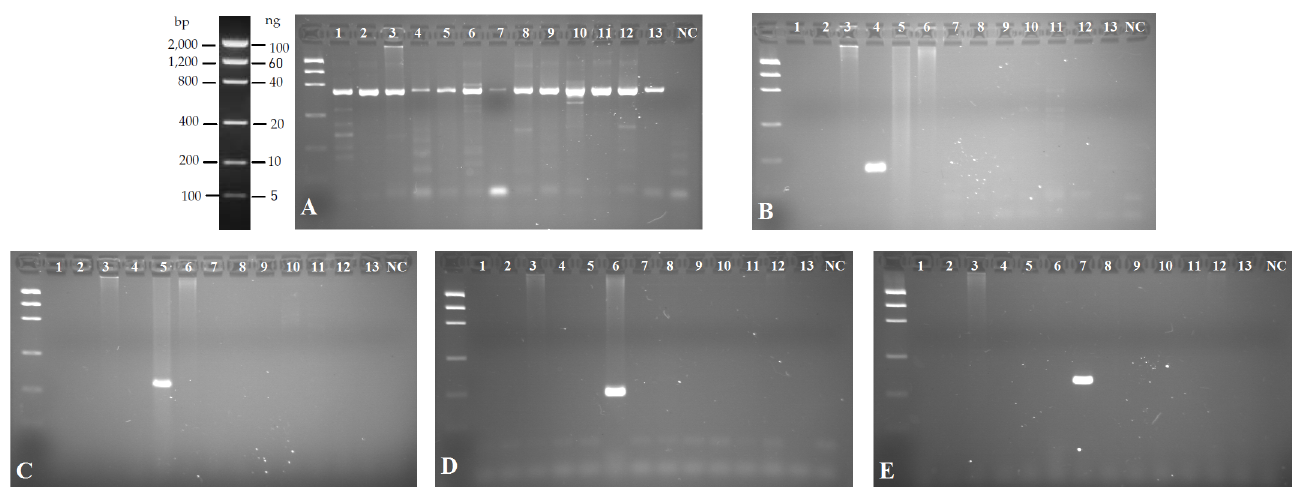
Fig 1. Agarose gels (2%) showing the results of cross-amplification experiments for each specific marker. PCR amplifiedwith: A) universal primers [48]; and specific primers for Corbiculasp . (B), Melanoides tuberculata (C), Mytilopsisleucophaeata (D); Sinanodontawoodiana (E). Lanes (from 1 to 13) in all gels are: Ladder, 1- Mya arenaria ,2- Rangiacuneata ,3- Dreissena polymorpha , 4- Corbicula fluminea ,5- Melanoidestuberculata , 6- Mytilopsis leucophaeata , 7- Sinanodonta woodiana , 8- Potamopyrgus antipodarum , 9- Bithynia tentaculata , 10- Salmo trutta , 11- Phoxinusphoxinus , 12- Carassius auratus , 13- Micropterus salmoides , NC- Negativecontrol.